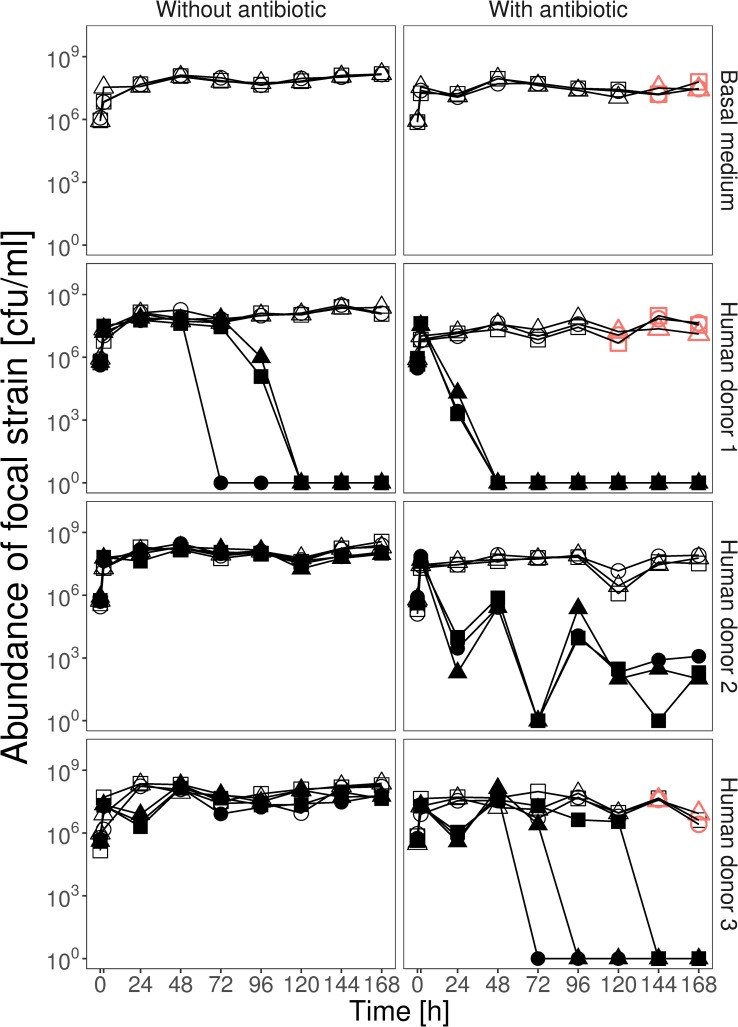
Resident microbial communities suppressed growth and resistance evolution of focal E. coli.Each panel shows abundance of the focal E. coli strain (in cfu per ml) over 7 d for either basal medium (top row) or with faecal slurry from one of three human donors, in the absence (left panels) or presence (right panels) of ampicillin, which was applied at the sampling time points after 2 h and thereafter at each daily transfer. Empty symbols show community-free treatments; filled symbols show treatments with the resident microbial community; red symbols show microcosms in which we detected ampicillin-resistant colony isolates of the focal strain. The three lines, each with different symbols, in each treatment show three replicate microcosms. Microcosms in which we detected no focal strain colonies are shown at 100. Data are deposited in the Dryad repository: https://doi.org/10.5061/dryad.t1g1jwszq [40]. cfu, colony-forming units.